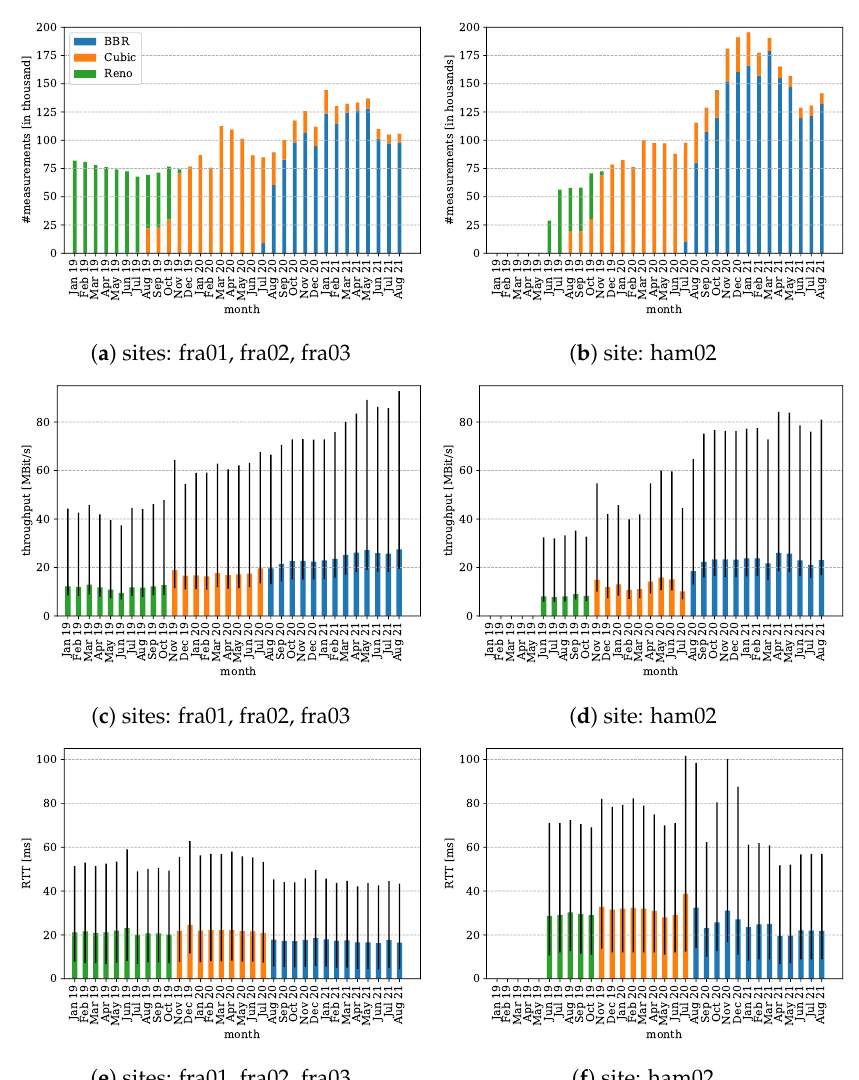
Figure 7. Number of measurements, throughput, and RTT per month for TCP Reno, TCP Cubic, and TCP BBR for three different machines from January 2019 to August 2021. For the throughput and RTT median, 25% and 75% percentiles are